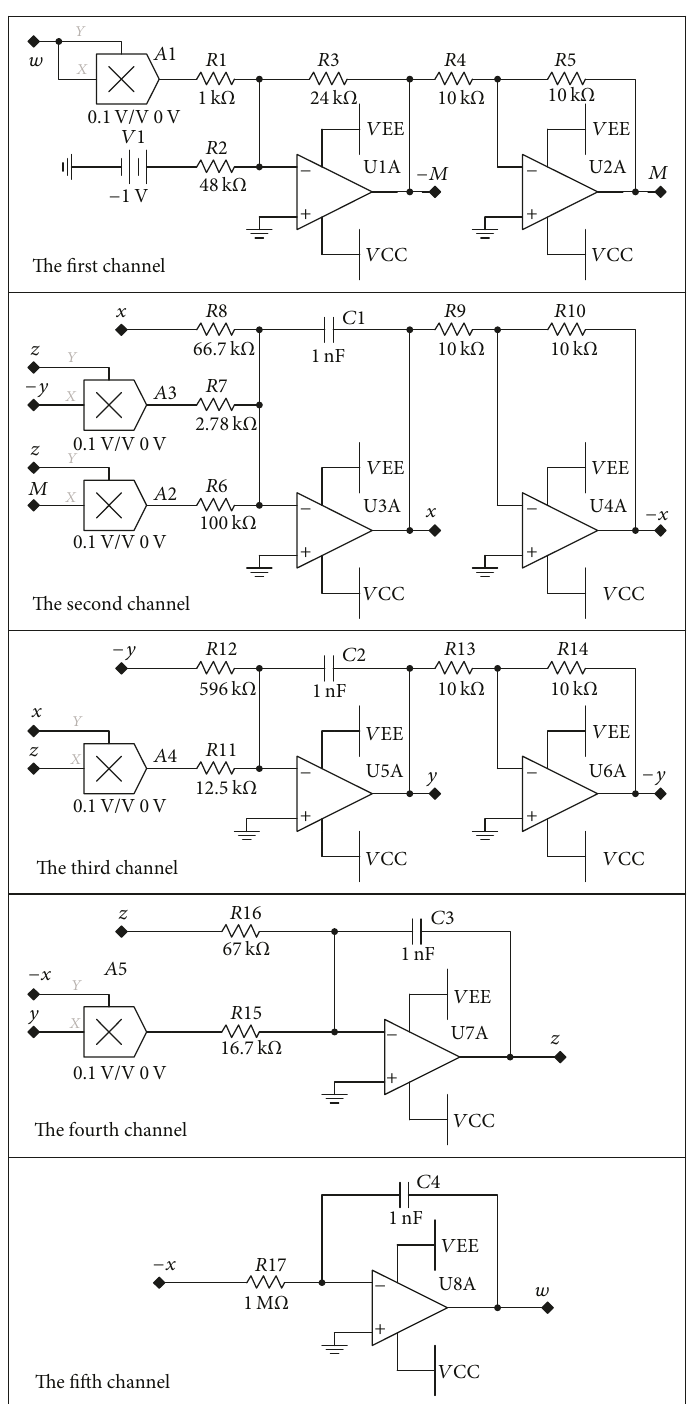
Figure 8: Circuit